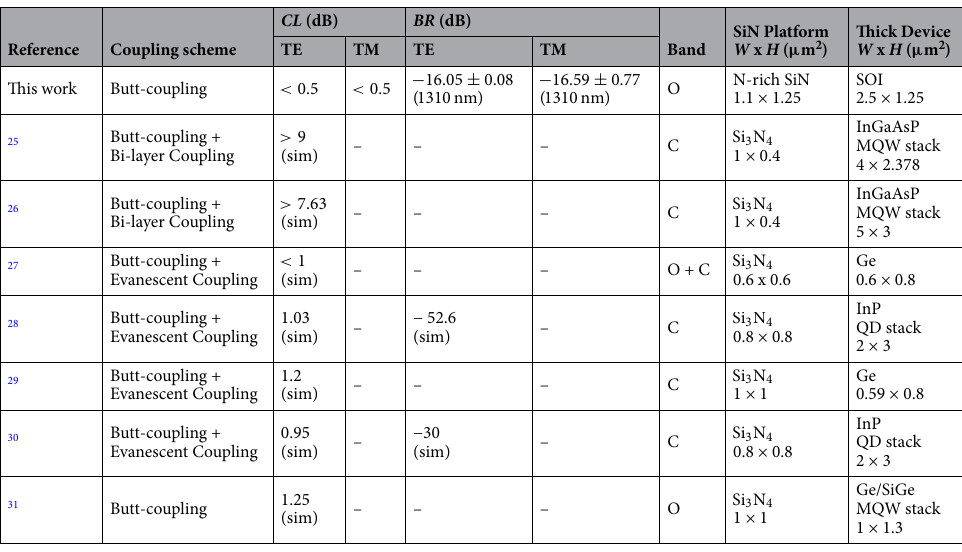
Table 3. Integration schemes in literature between SiN waveguides and thick devices compared to the scheme under investigation of the underlying work. The SiN waveguides noted refer to the related single-mode sections. The thick III-V buffers are not taken into account for the total thickness of the III-V stacks.